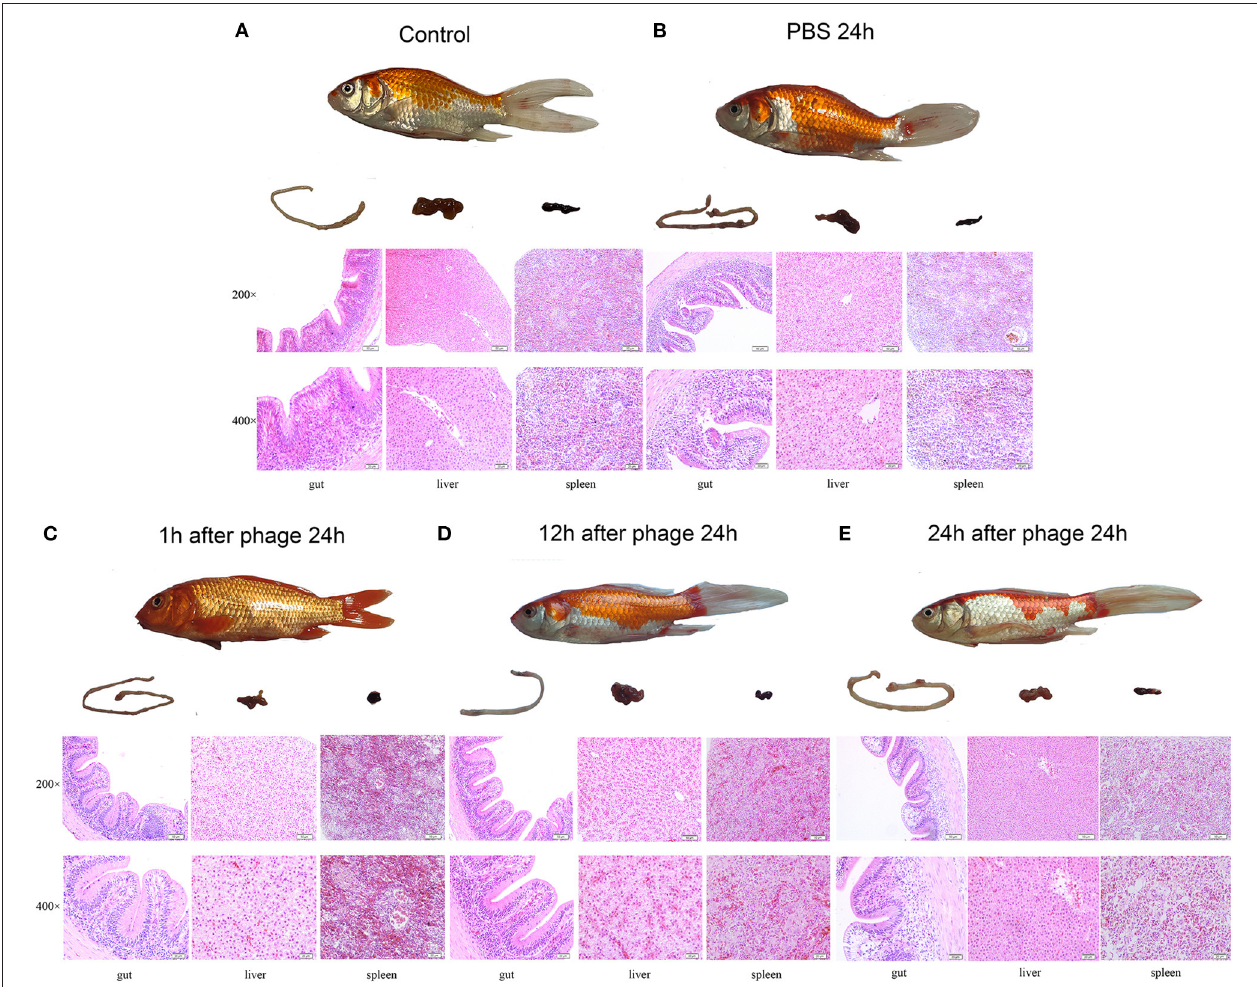
FIGURE 6 | Gross pathology and histopathology. The crucian carp were infected with Cbr-1 (2 × 10 9 CFU/fish) and then treated with PBS or 1 × 10 9 PFU vB_CbrM_HP1 at different time points. The gut, liver and spleen tissues were removed from the crucian carp 24h after treatment with PBS or the phage and then stained with haematoxylin and eosin. (A) The gut, liver, and spleen of the healthy crucian carp; (B) 1h after treatment with PBS; (C) 1h after treatment with vB_CbrM_HP1; (D) 12h after treatment with vB_CbrM_HP1; (E) 24h after treatment with vB_CbrM_HP1.